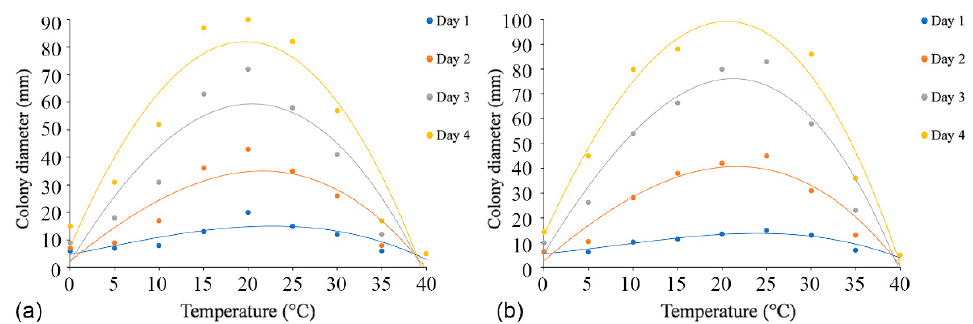
Figure 6. Effects of temperature on the growth of Cytospora species. ( a ) Cytospora alba (CFCC 55462): y Day1 = − 0.0005x 3 + 0.0035x 2 + 0.6438x + 4.6768 (R 2 = 0.7348); y Day2 = − 0.0009x 3 − 0.033x 2 + 2.6289x + 2.3212 (R 2 = 0.8171); y Day3 = − 0.0007x 3 − 0.1103x 2 + 5.3437x + 1.9394 (R 2 = 0.8513); y Day4 = − 0.0004x 3 − 0.1762x 2 + 7.4157x + 7.4949 (R 2 = 0.9055). ( b ) Cytospora paracinnamomea (CFCC 55453): y Day1 = − 0.0006x 3 + 0.0147x 2 + 0.3385x + 5.5222 (R 2 = 0.8937); y Day2 = − 0.0009x 3 − 0.0406x 2 + 3.0735x + 2.7606 (R 2 = 0.9161); y Day3 = − 0.0017x 3 − 0.0843x 2 + 5.8622x + 5.7758 (R 2 = 0.944); y Day4 = − 0.0014x 3 − 0.1473x 2 + 7.7947x + 13.211 (R 2 = 0.9641).